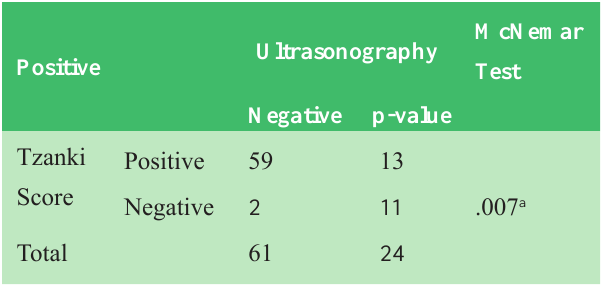
Table 1: Comparison of ultrasonography abdomen